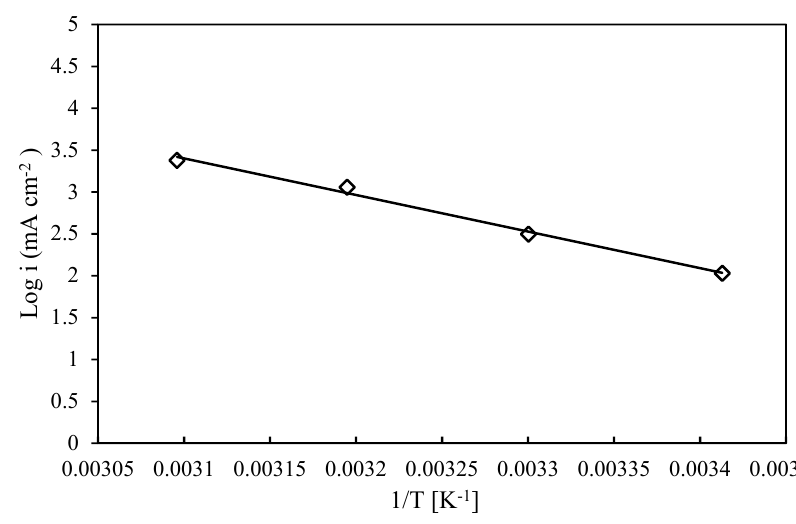
Figure 3. Arrhenius plots for the corrosion current of carbon steel in GTL process water solution.